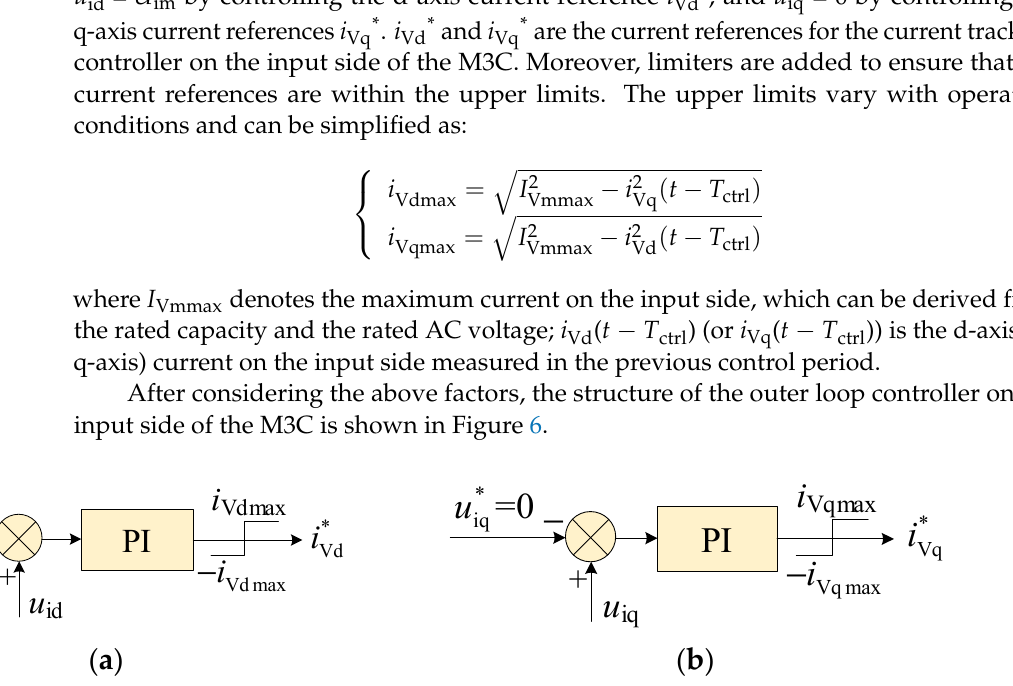
Figure 6. Outer loop controller on the input side of M3C: ( a ) d-axis controller; ( b ) q-axis controller.